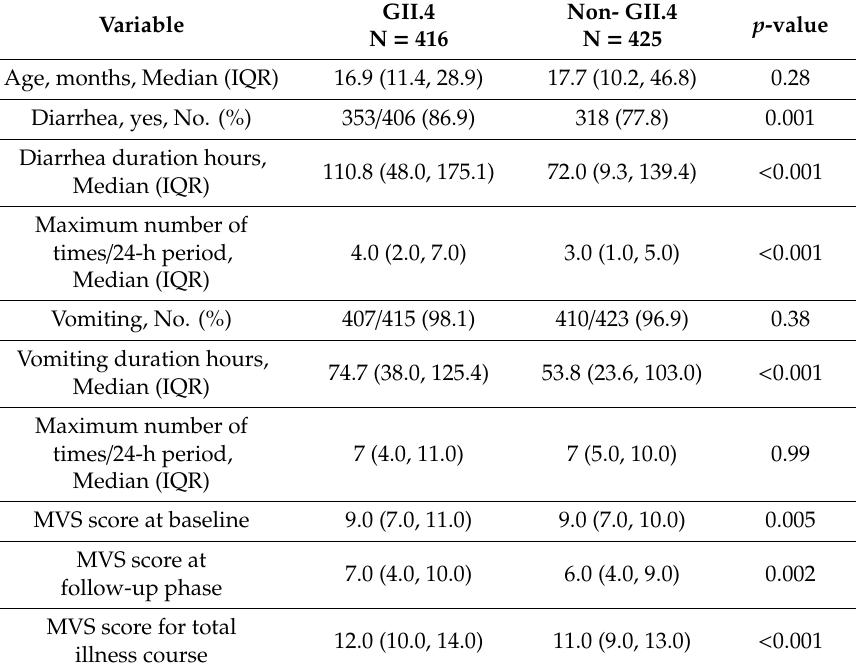
Table 4. Clinical characteristics of Norovirus GII.4 vs. non-GII.4 Positive